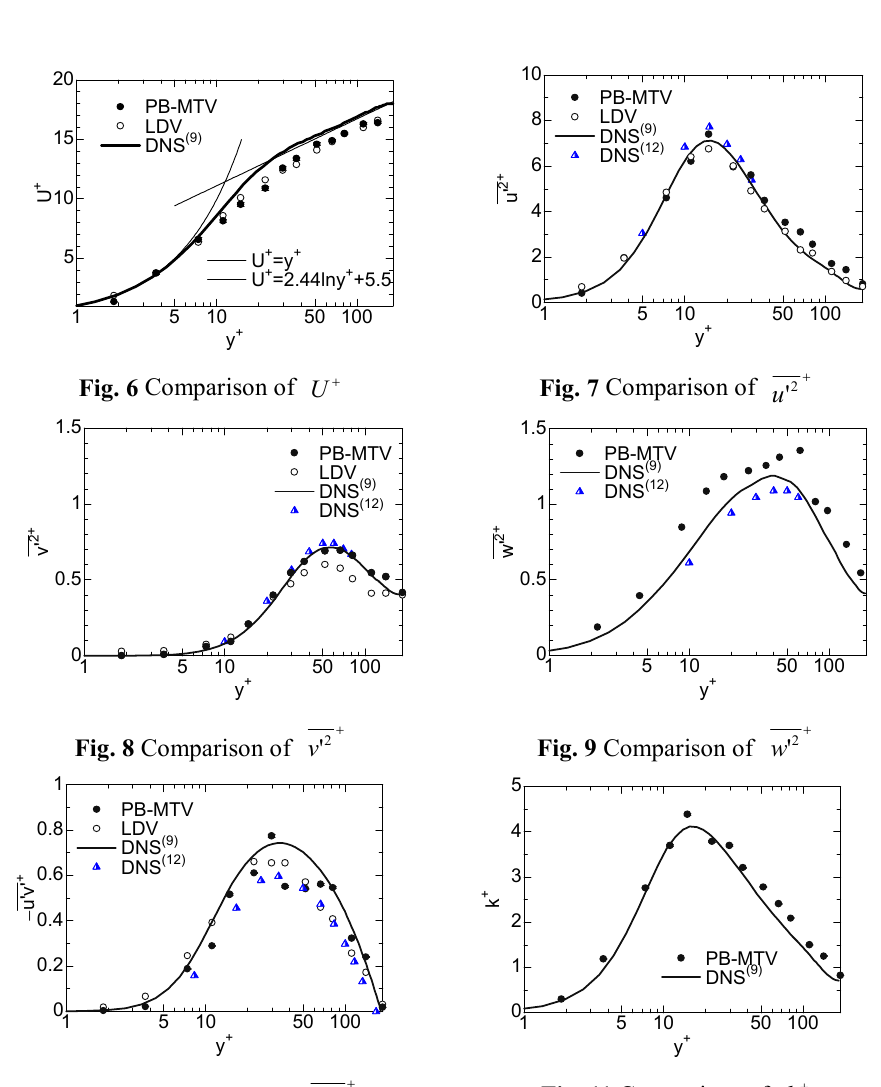
Fig. 10 Comparison of Fig. 11 Comparison